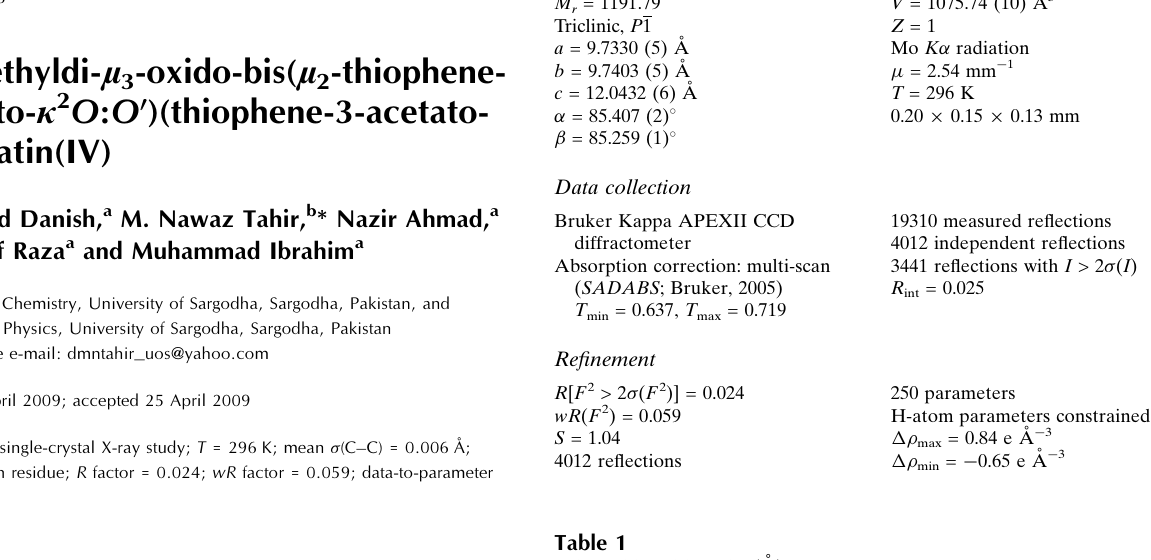
Selected bond lengths (A˚ ).